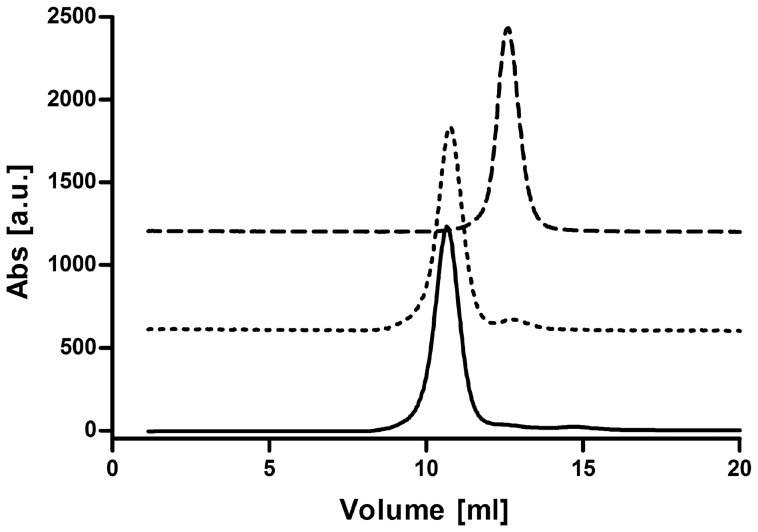
Stacked SEC elution profiles of wt-rcII (−), rcII-SdhB-His6 (−) and rcII-His8-SdhB (…).